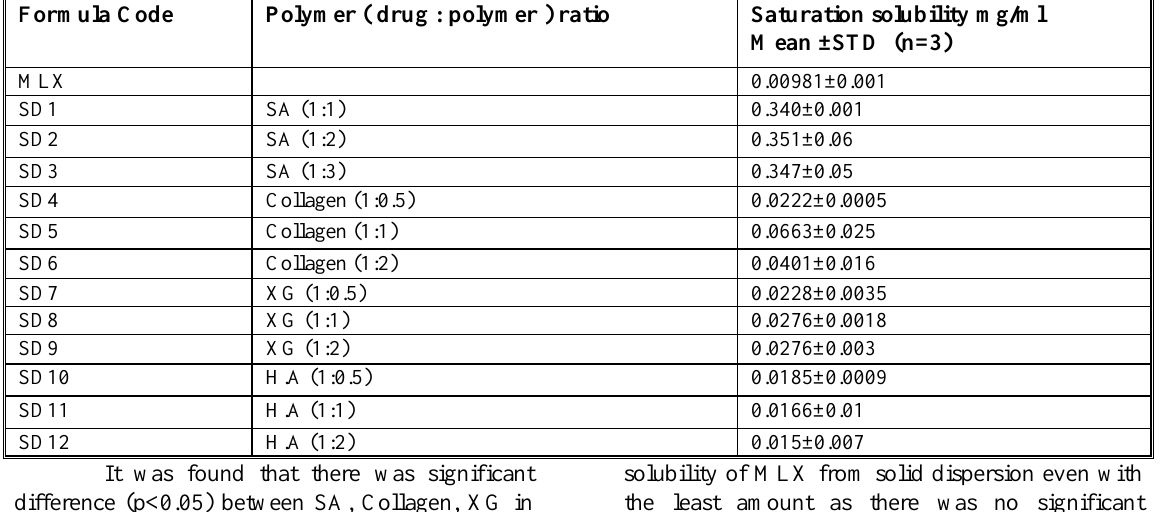
Table 3.The Saturation solubility of pure MLX and SDs formulas using different natural polymers with different Drug: Polymer ratio in distilled water at